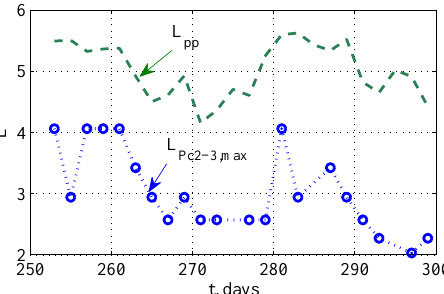
Figure 11. Day-to-day variations of the position of maximal Pc2-3 occurrence rate at CHAMP, in the 00:00-06:00MLT sector for two months in 2007, and the plasmapause position, determined from the two-day mean Kp with Carpenter’s